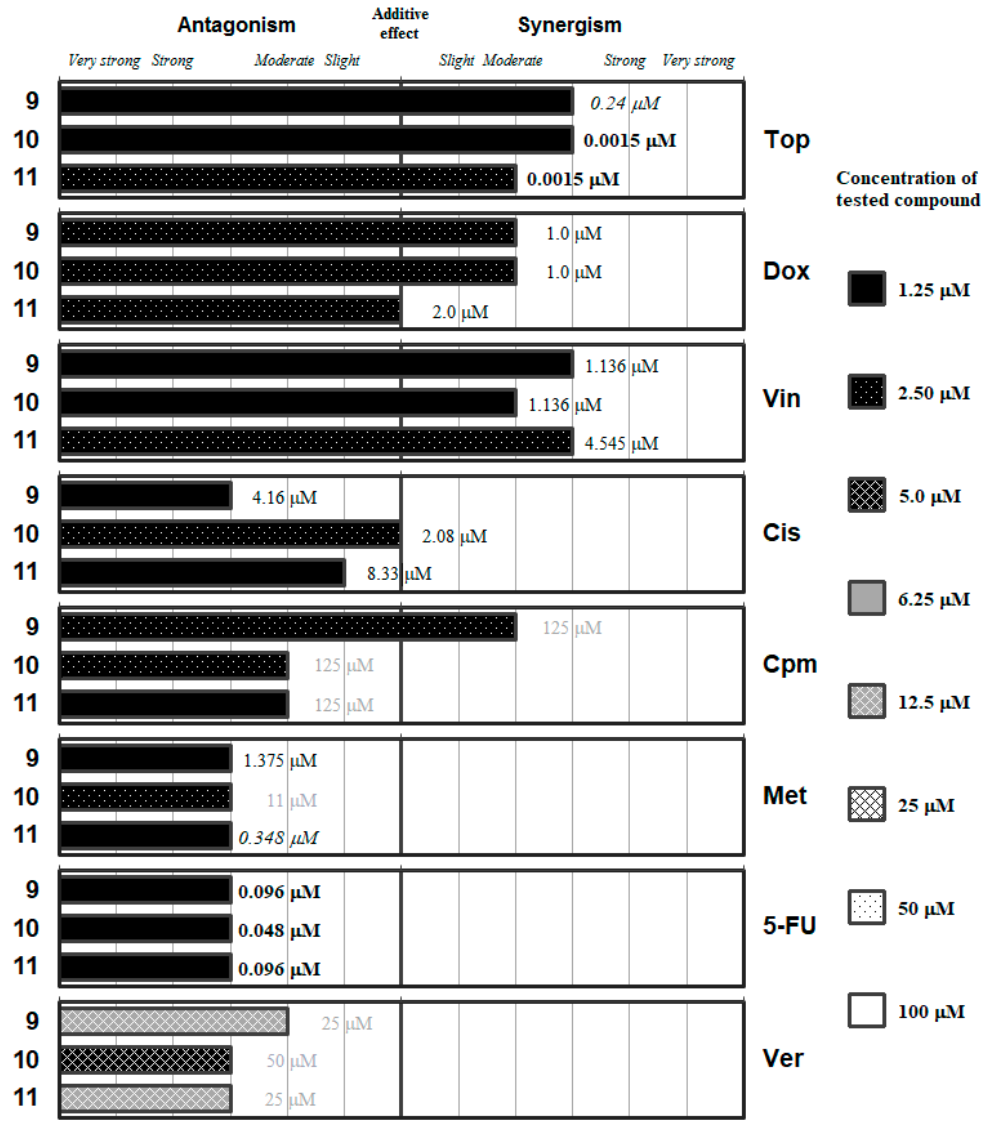
Figure 5. Interactions of the ketone ‐ containing selenoesters ( 9 – 11 ) with a panel of anticancer drugs ( Top , Dox , Vin , Cis , Cpm , Met and 5 ‐ FU ) or an efflux pump inhibitor ( Ver ). Concentration of the